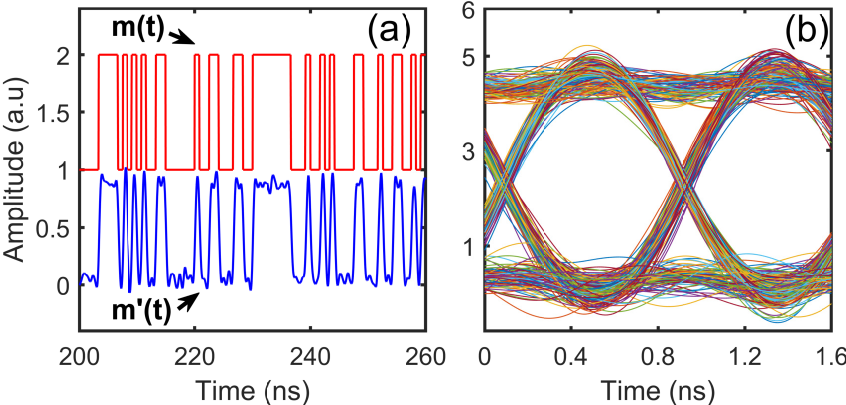
Figure 9. Results of unidirectional message encoding and decoding using CSK scheme for J m = 1.10 I th